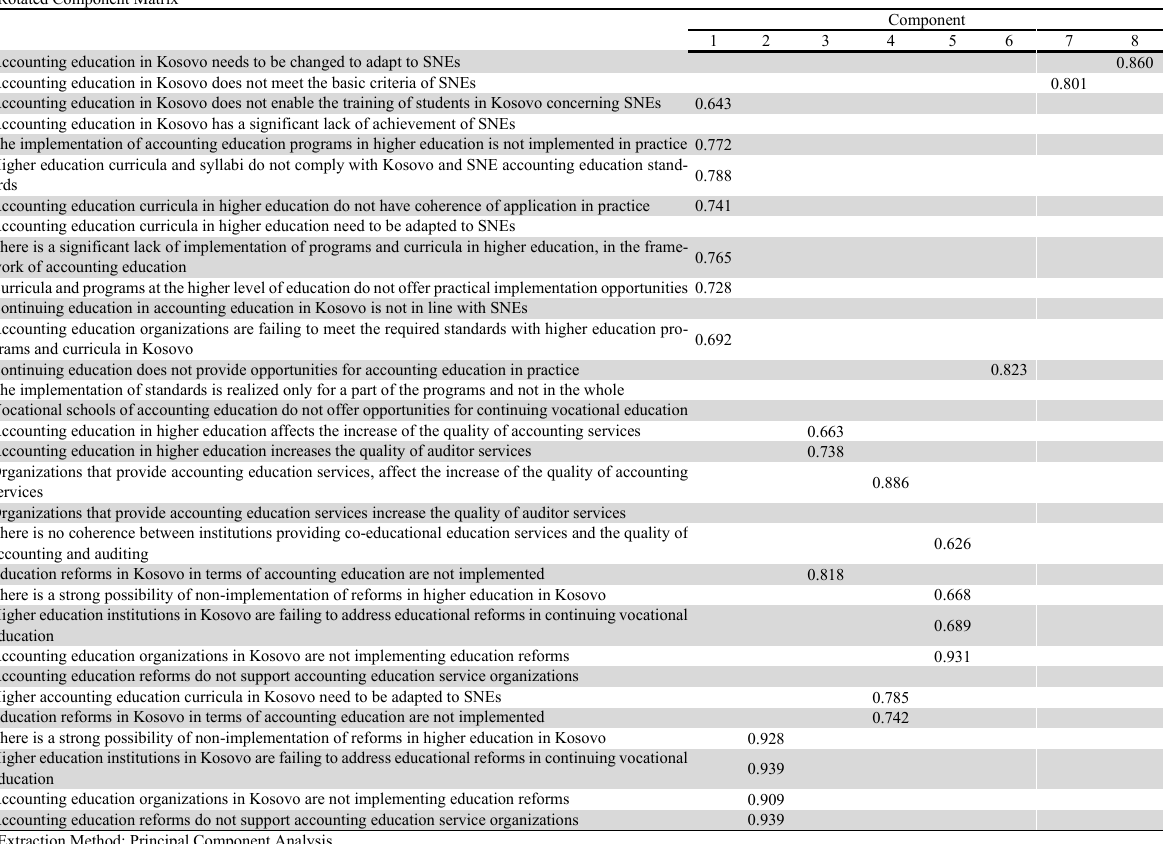
Table 21 lists the variables that have reached a value above 0.60 of the correlation coefficient. The variables are separated in the first component (Accounting education in Kosovo does not enable the training of students in Kosovo in relation to SNES = 0.643, The implementation of accounting education programs in higher education is not implemented in practice = 0.772, Higher education curricula and syllabi do not comply with Kosovo and SNE accounting education standards = 0.788, Table 21 Rotated Component